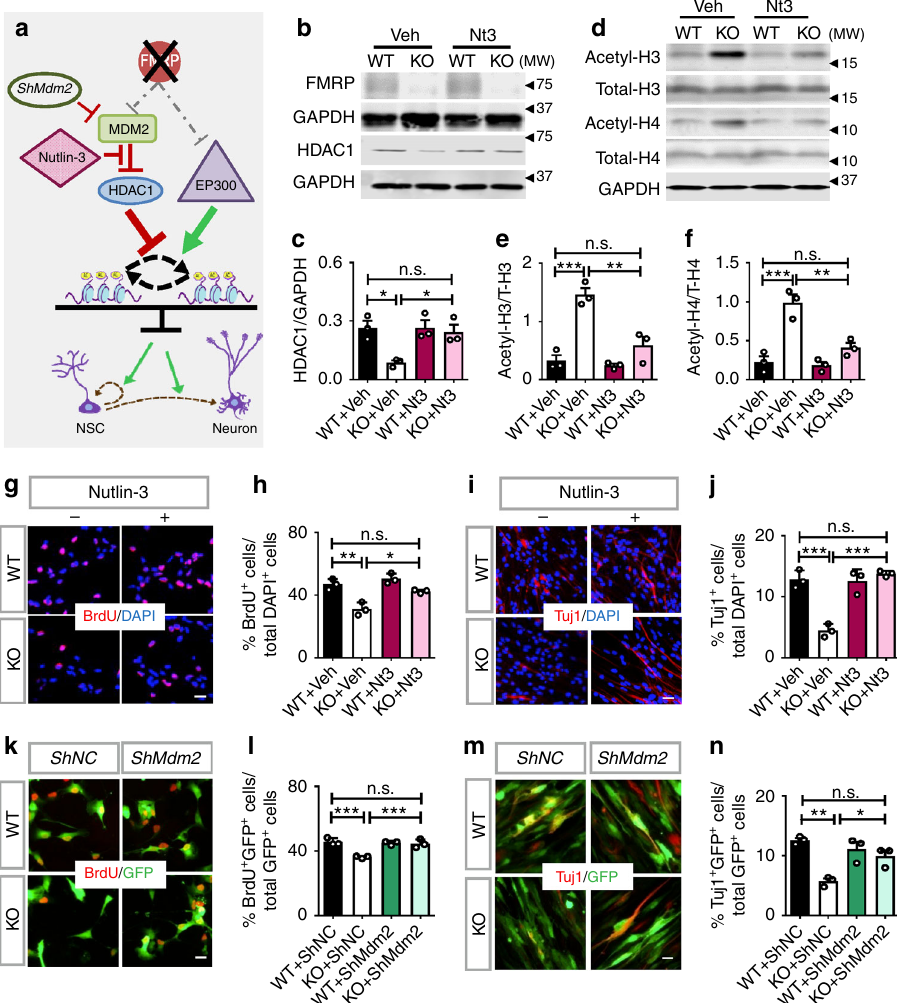
Fig. 5 Increasing HDAC1 rebalances histone acetylation and rescues proliferation and differentiation de fi cits of FMRP-de fi cient NPCs. a A schematic model showing that enhancing HDAC1 activities through either pharmacological or genetic reduction of MDM2 rebalances histone acetylation and rescues proliferation and differentiation of Fmr1 KO NPCs. b , c Western blot analyses of HDAC1 and FMRP protein levels in 6-mo NPCs treated with Nutlin-3 ( n = 3). GAPDH was used as a loading control. d – f Western blot analyses of total and acetylated histone H3 ( d , e ) and histone H4 ( d , f ) in NPCs treated with Nutlin-3 ( n = 3). Total histone H3 and total histone H4 were used as loading controls for acetylated H3 and H4, respectively. g , h Nutlin-3 treatment rescued the cell proliferation phenotype of Fmr1 KO NPCs as measured by BrdU incorporation ( g , red; scale bar, 20 µ m) followed by quantitative analysis ( h , n = 3). i , j Nutlin-3 treatment rescued neuronal differentiation phenotypes of Fmr1 KO NPCs as assessed by Tuj1 + staining ( i , red; scale bar, 20 µ m) followed by quantitative analysis ( j , n = 3). k , l Acute knockdown of MDM2 rescued the cell proliferation phenotype of Fmr1 KO NPCs as assessed by incorporation of the thymidine analog, BrdU ( l , red, BrdU; green, GFP, scale bar, 20 µ m) and quantitative analysis ( l , n = 3). m , n Acute knockdown of EP300 rescued neuronal differentiation phenotypes of Fmr1 KO NPCs as assessed by a neuronal marker Tuj1 + ( m , red, Tuj1; green, GFP, scale bar, 20 µ m) followed by quantitative analysis ( n , n = 3). * P < 0.05, ** P < 0.01, *** P < 0.001, n.s.: no signi fi cant difference. Two-way ANOVA was used for all data analyses. Data are presented as mean ±